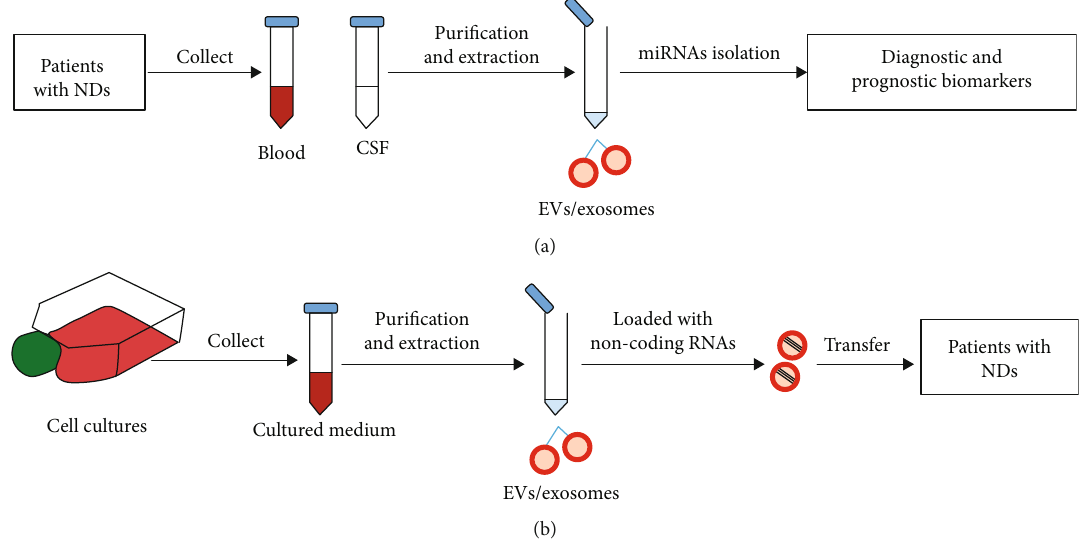
Figure 1: Collection and clinical applications of EVs/exosomes: (a) EVs/exosomes as therapeutic vehicles; (b) EVs/exosomes as diagnostic and prognostic